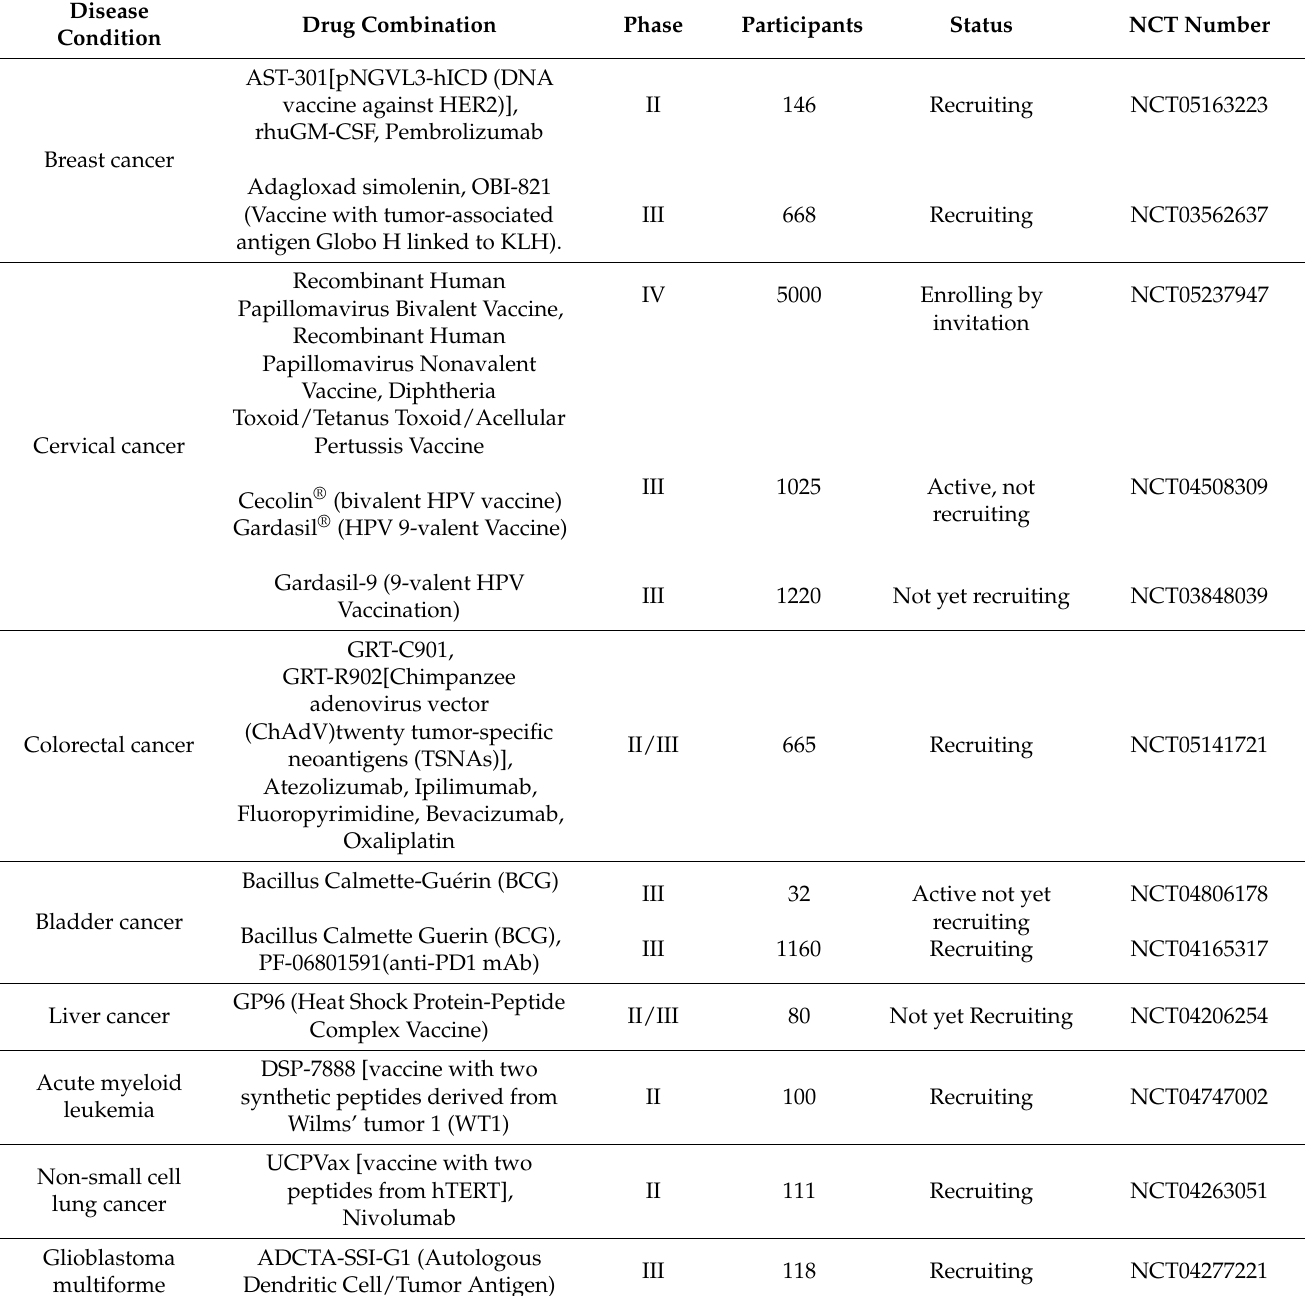
Table 3. List of some of the selected ongoing cancer vaccine clinical trials that are in phase